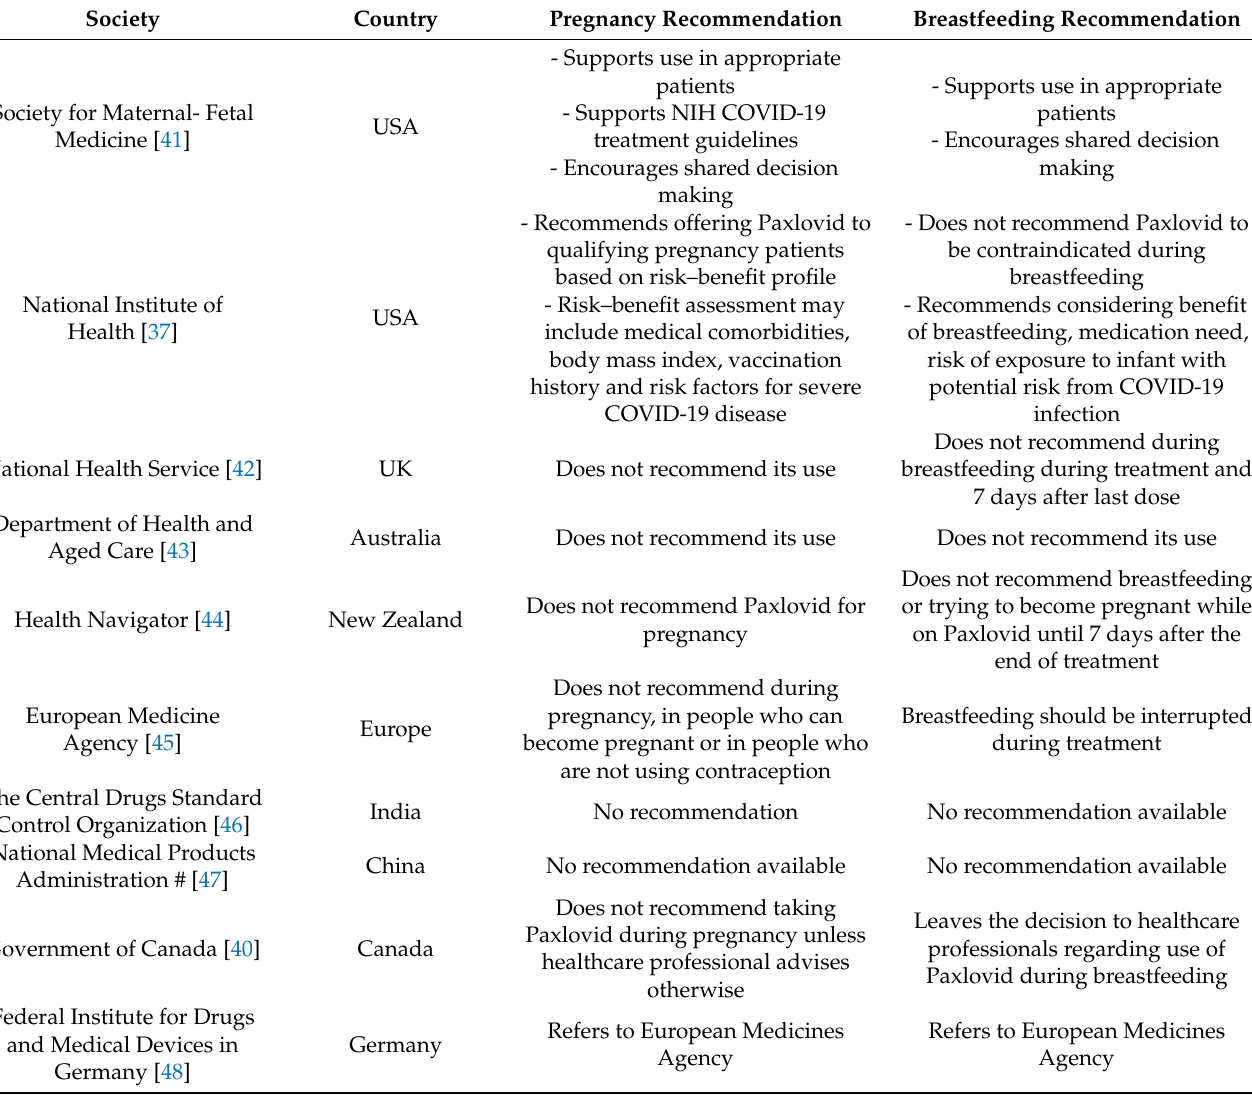
Table 2. Current recommendation regarding Paxlovid use in pregnant and breastfeeding females from major international